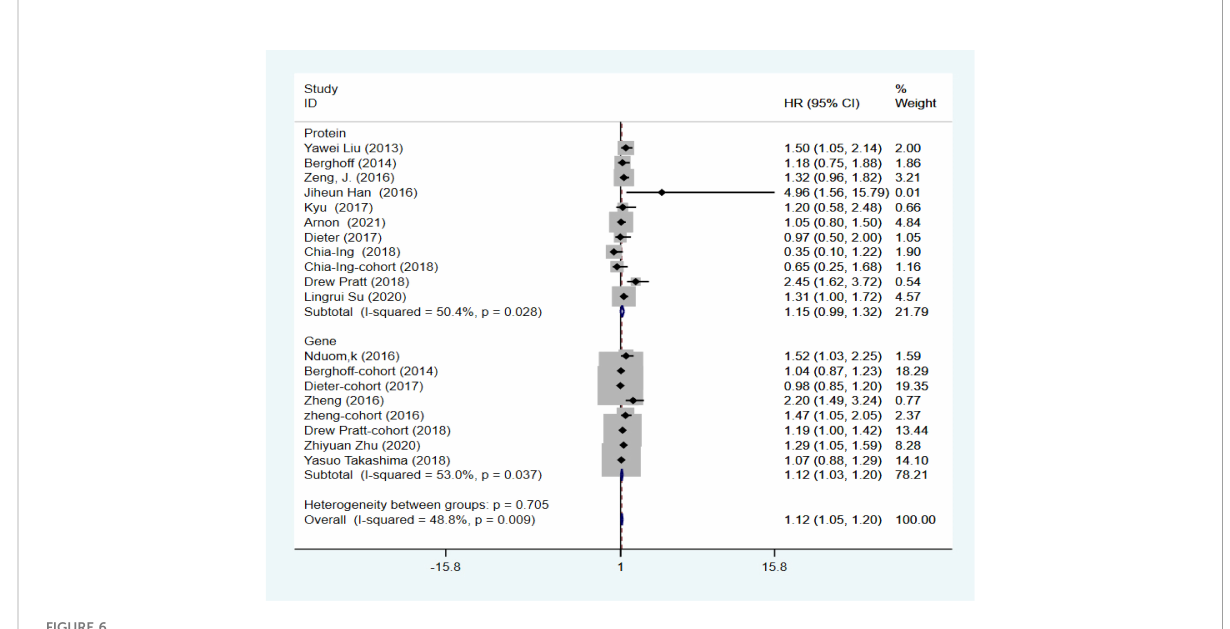
FIGURE 6 Subgroup analysis of PD-L1 expression in genes and